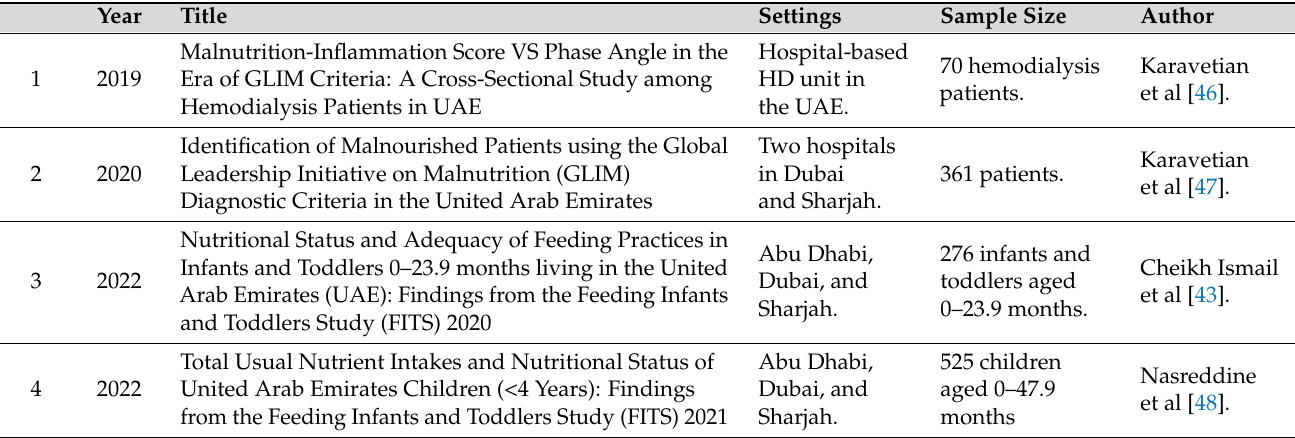
Table 1. Energy Malnutrition (stunting, wasting,